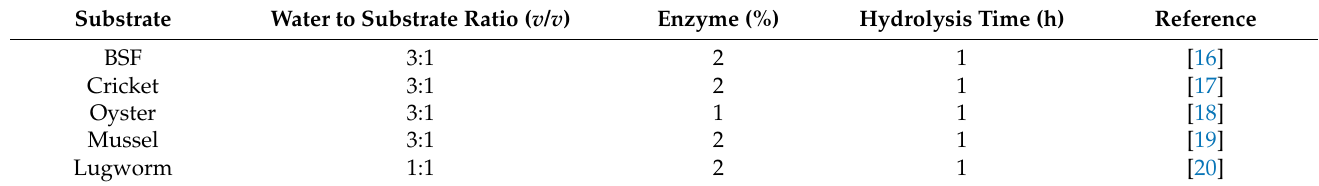
Table 1. Specific reaction conditions for enzymatic hydrolysis of